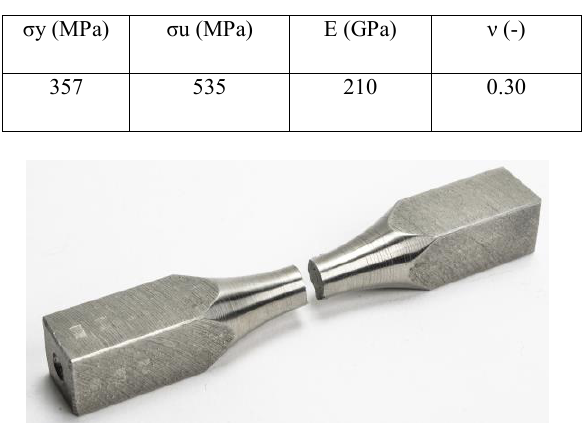
Fig. 2. The exemplary hourglass specimen after fatigue test.